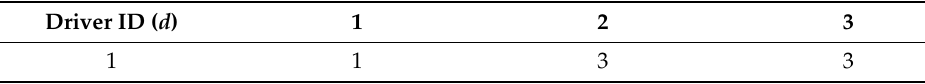
Table 12. Γ d for Drivers.